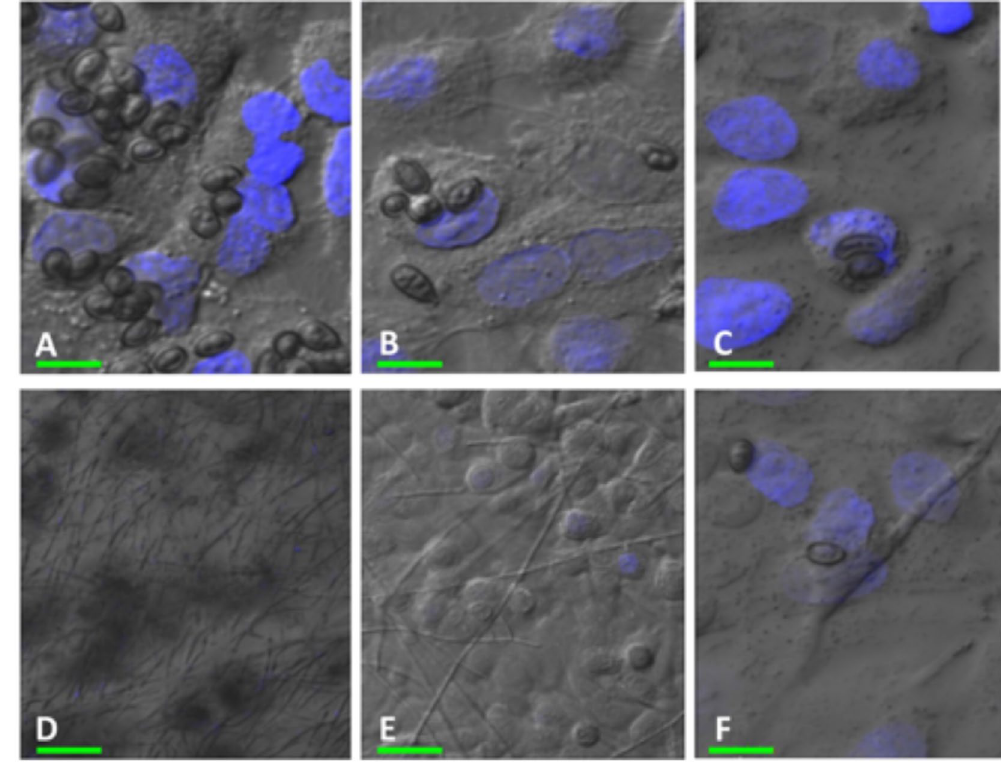
Figure 2. Confocal laser scanning microscopy (CLSM) images of the co-culture of S. aurantiacum strain WM 06.482 and A549 cell monolayers after 4 h and 24 h of incubation at 37 °C. The epithelial cells were stained with nucleic acid specific stain Hoechst 33342 (shown in blue). A549 cells after incubation with WM 06.482 conidia ( A , D ) MOI = 10:1, ( B , E ) MOI = 1:1 and ( C , F ) MOI = 0.1:1 for 4 h ( A – C ) and 24 h ( D – F ), respectively. Scale bars (in green): ( A ) = 5 µ m, ( B , C and F ) = 10 µ m and ( D , E ) = 20 µ